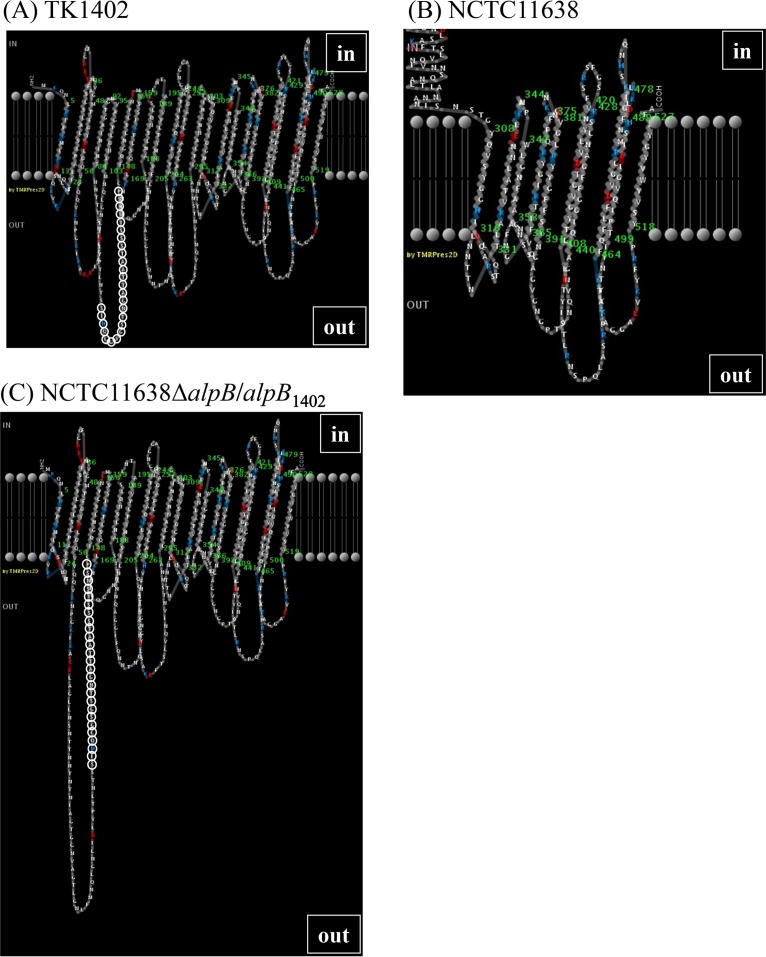
Two-dimensional structure of AlpB from TK1402 (A), NCTC11638 (B), and NCTC11638ΔalpB/alpB1402 (C) strains based on the prediction by PRED-TMBB. The amino acids of the variable region are shown in open circles, except for NCTC11638. In this strain, the variable region was located further upstream than the displayed amino acids, in an intracellular location, and therefore is not shown in this figure. The NCTC11638ΔalpB/alpB1402 strain was a restored strain derived from the NCTC11638 alpB mutant restored with TK1402 alpB.